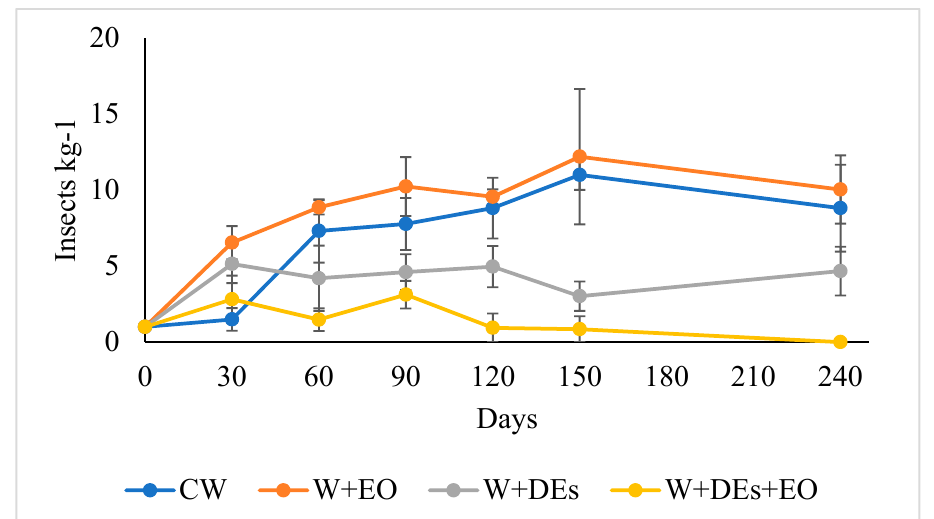
Figure 2. Temporal evolution of the beetles infestation of the stored in the mini-silos during the trial (240 day). CW, control wheat; W + EO, wheat treated with the essential oil of Ocimum basilicum ; W + DEs, wheat treated with diatomaceous earths; W + Des + OE, wheat treated with O. basilicum essential oil and diatomaceous earths. Data represent the mean number of adults kg − 1 of grain. Bars represent the standard error.